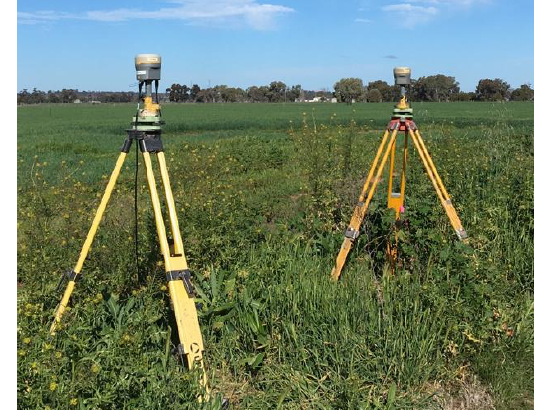
Figure 6 : Field data collection using GNSS receivers